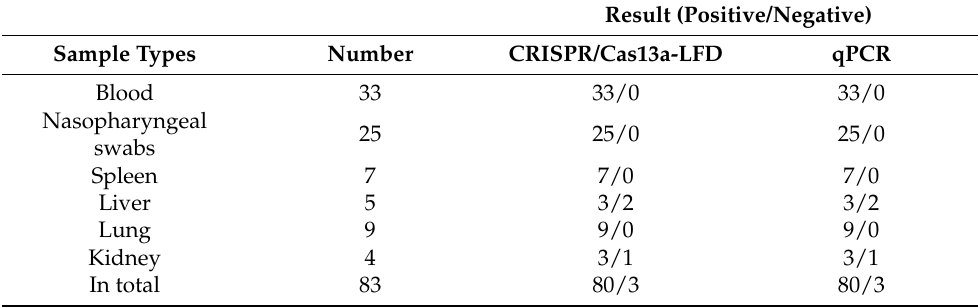
Table 4. The coincidence rate between the CRISPR/Cas13a-LFD and real-time qPCR for the ASFV detection in clinical samples.